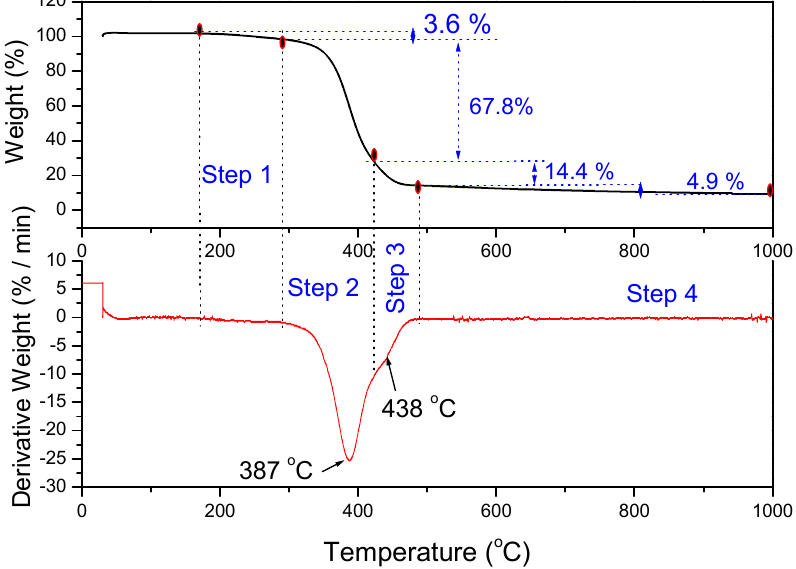
◦ C / min under nitrogen